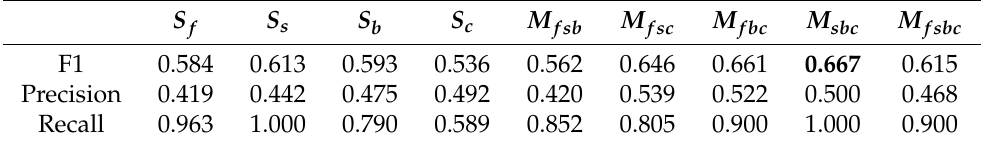
Table 7. Performance of inducible emotion recognition of Driver B.